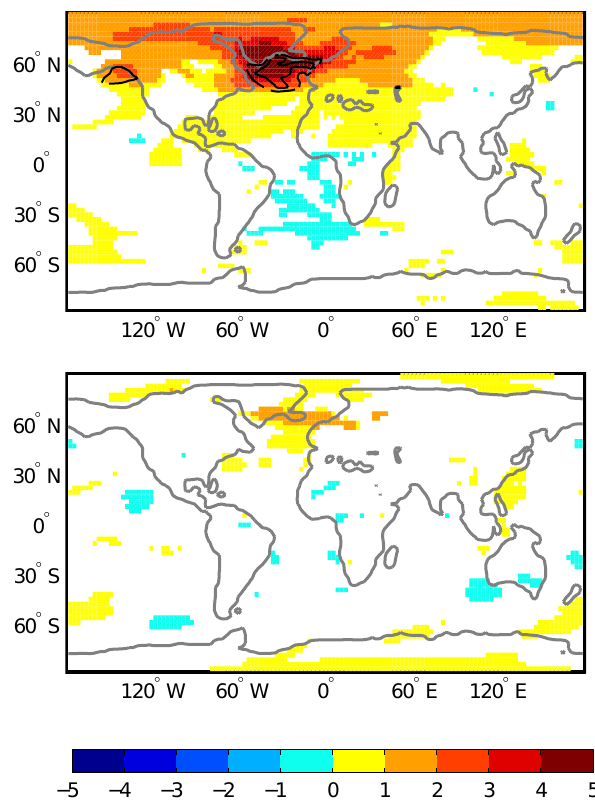
Fig. 2. January–March T 2m (shading) and sea ice concentration (SIC) (contours at − 10% and − 20%). Difference between the last century of the simulation (model years 1440–1539) and model years 500–599 (top panel) and model years 1000–1099 (bottom panel). Units are ◦ C and %, respectively. Only statistically significant dif- ferences (at the 95% level) are displayed. The coastline is defined at 20% of the land